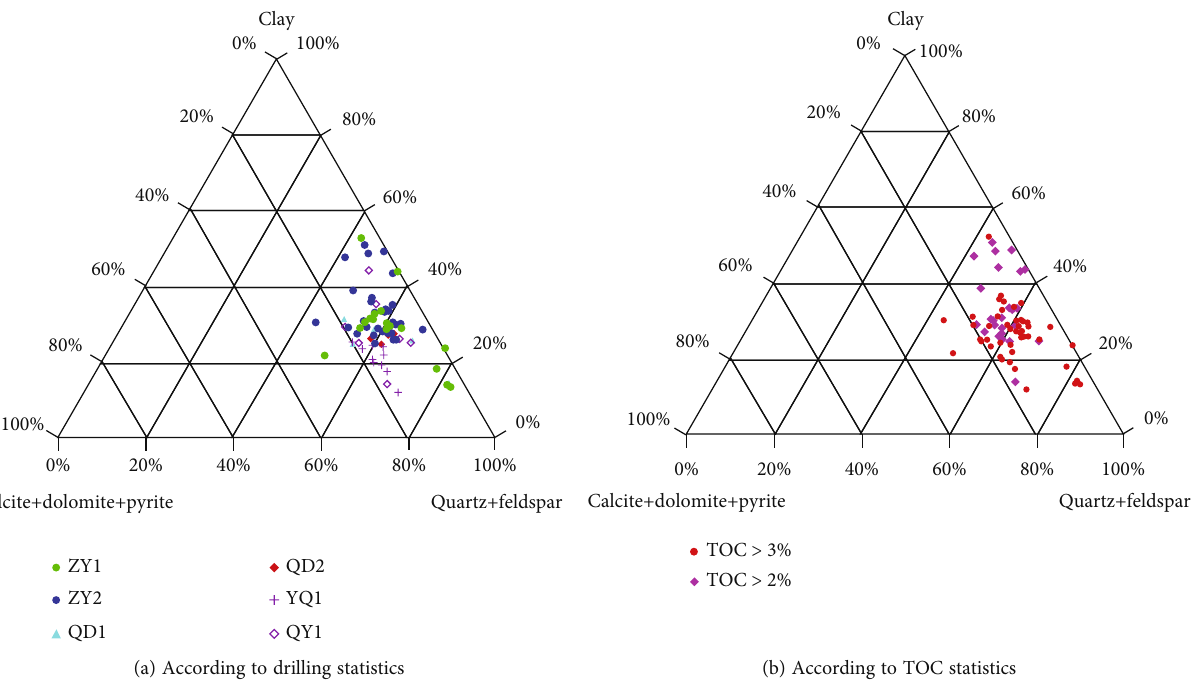
Figure 4: Triangle diagram of mineral composition of black shale in Wufeng-Longmaxi Formation in Qianjiang area, southeast Chongqing. Table 1: Statistics of lithofacies characteristics of black shale in Wufeng-Longmaxi Formation in Qianjiang area. Well